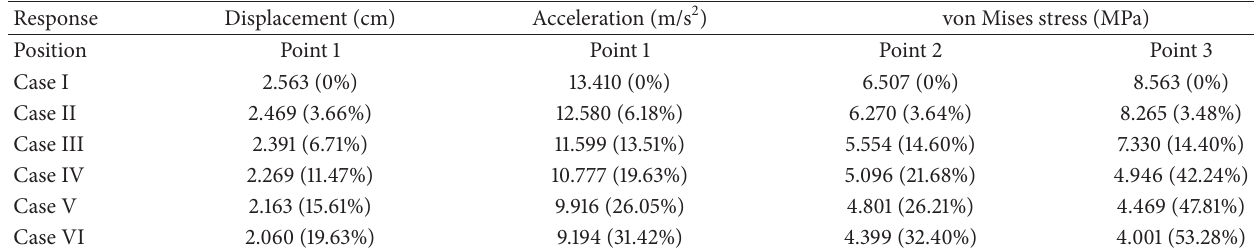
Table 4: The maximum transient data and the relative difference compared with Case